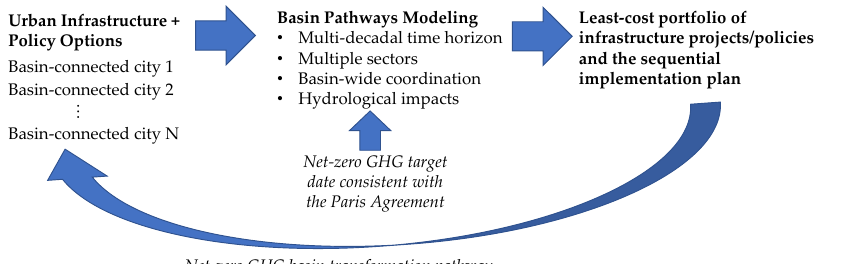
Fig. 1 Basin pathways modeling incorporating urban infrastructure and policy options across basin-connected cities informs the economic optimization of net-zero GHG transformations under constrained water resources. Multiple sectors, decades and spatial scales are represented simultaneously to identify a least-cost portfolio of projects and policies and the sequential implementation